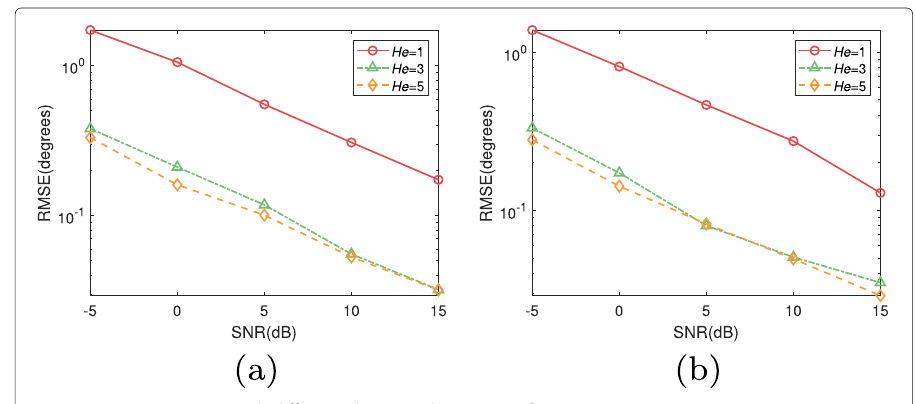
Fig. 4 RMSEs versus SNR with different phase modes. a M =24. b M =32